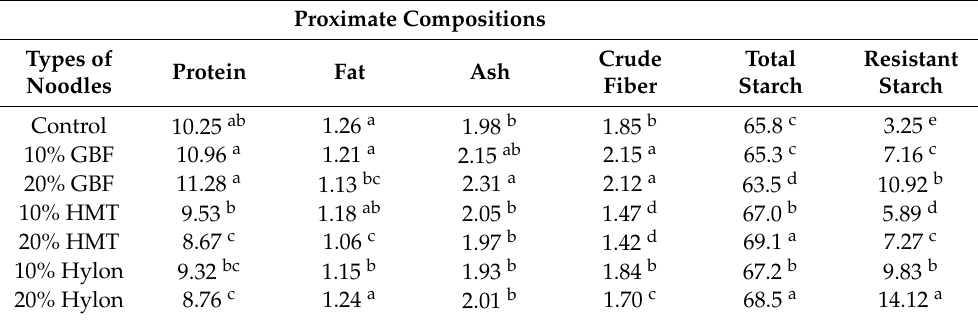
Table 3. Proximate compositions, total starch content, and resistant starch content of cooked salted noodles containing different proportions of resistant starch source